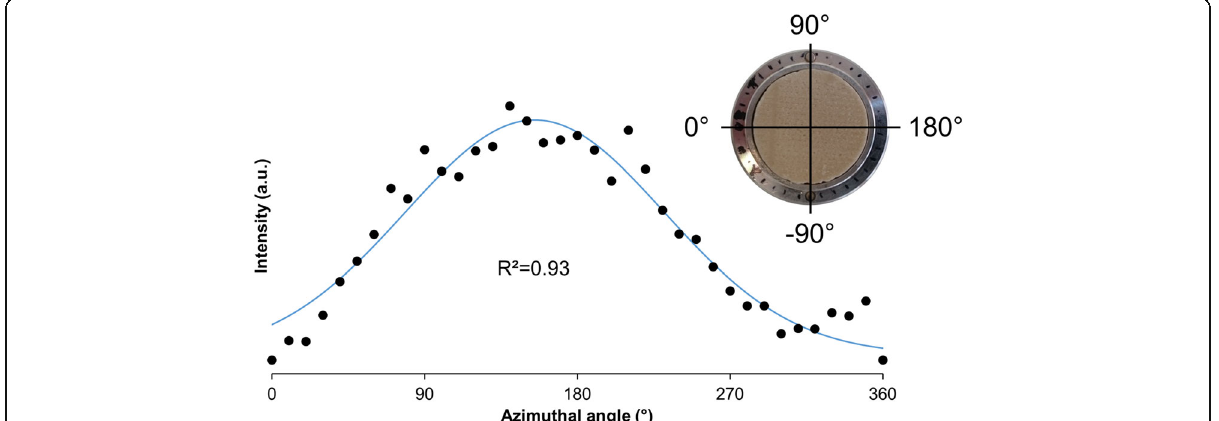
Fig. 6 Diffraction intensity (a.u.) versus azimuthal angle (°) of the AC50% specimen and the Gauss-shaped fitting curve. The fiber alignment is calculated by the value of the angle (Z) for the width of the diffraction at one half the maximum